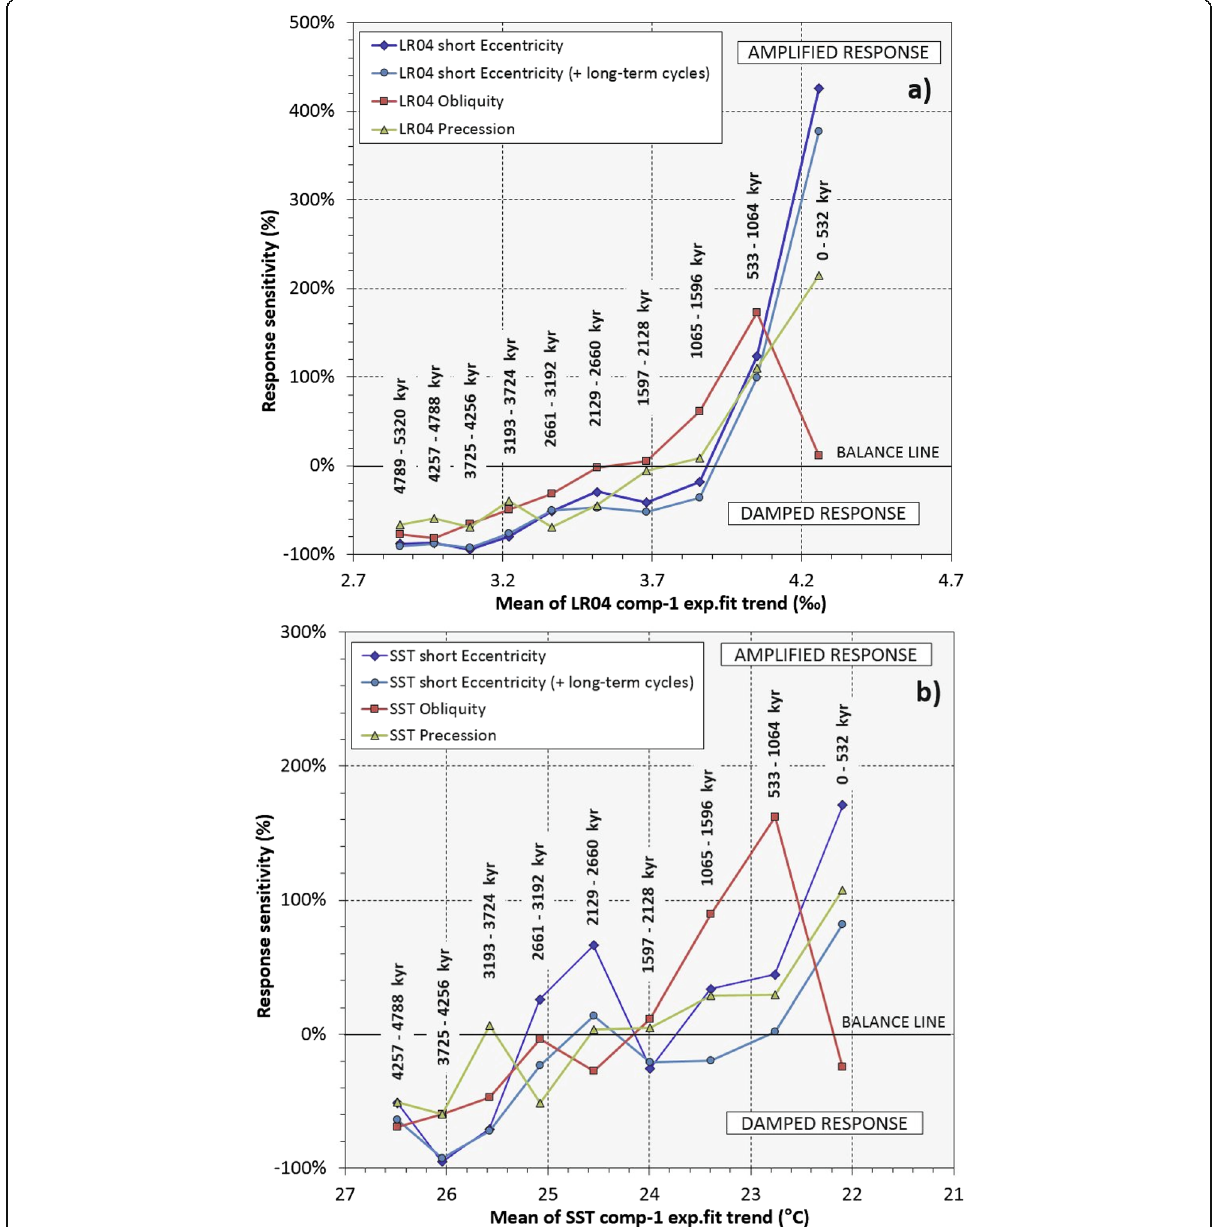
Fig. 11 Analysis of the order of magnitude in a δ 18 O and b SST response modulation relative to orbital forcing (standardized response sensitivity R s , see text) as a function of the LT-MCS. The balance line (0%) indicates that the variance of response matches the variance in forcing, suggesting a self- sustained climate system, which is only paced by orbital cycles. Values much larger than zero would indicate a nonlinear reinforcement of the signal response. Negative R s shows a response variance lower than orbital forcing, suggesting a damping mechanism for the climate